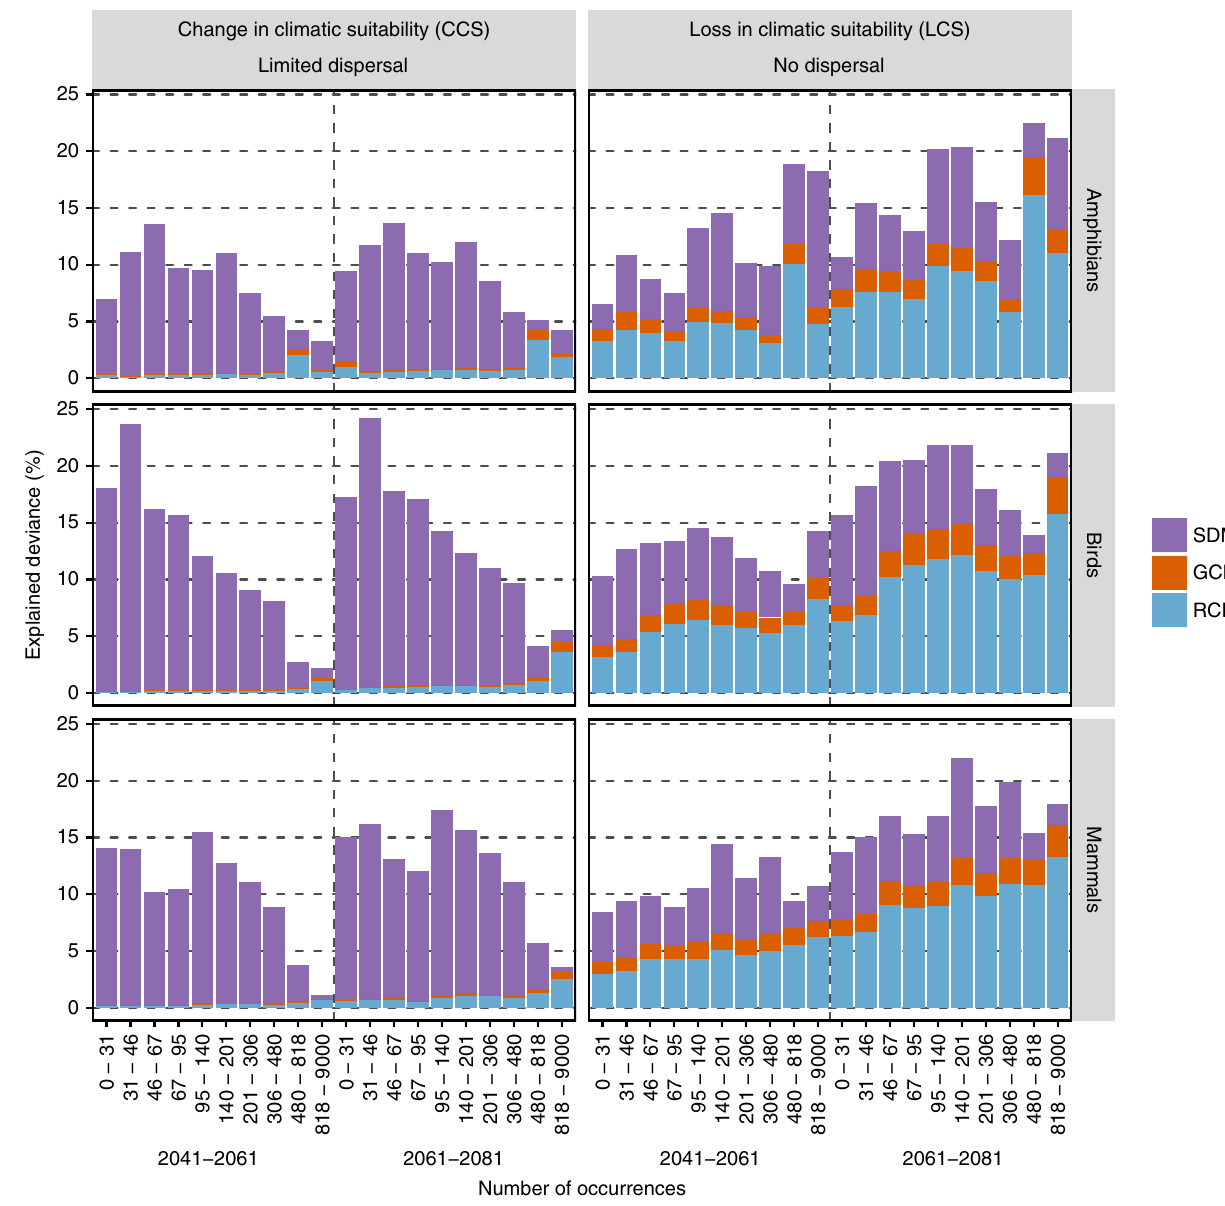
Fig. 2 Relative in fl uence of the different sources of variation on species ’ level sensitivity metrics in function of species range size. The plot represents the relative in fl uence of SDMs, GCMs, and RCPs on overall species sensitivity to climate change in response to species ’ range size. A TSS threshold of 0.7 was used for all analyses. Species ranges were classi fi ed for equal size at the log